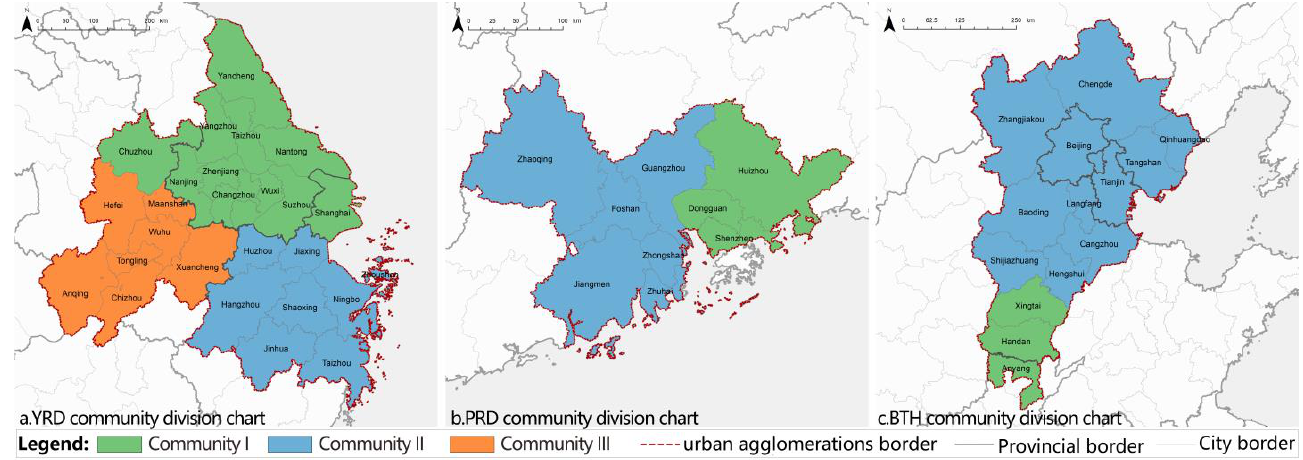
Figure 6. Community distribution of three major urban